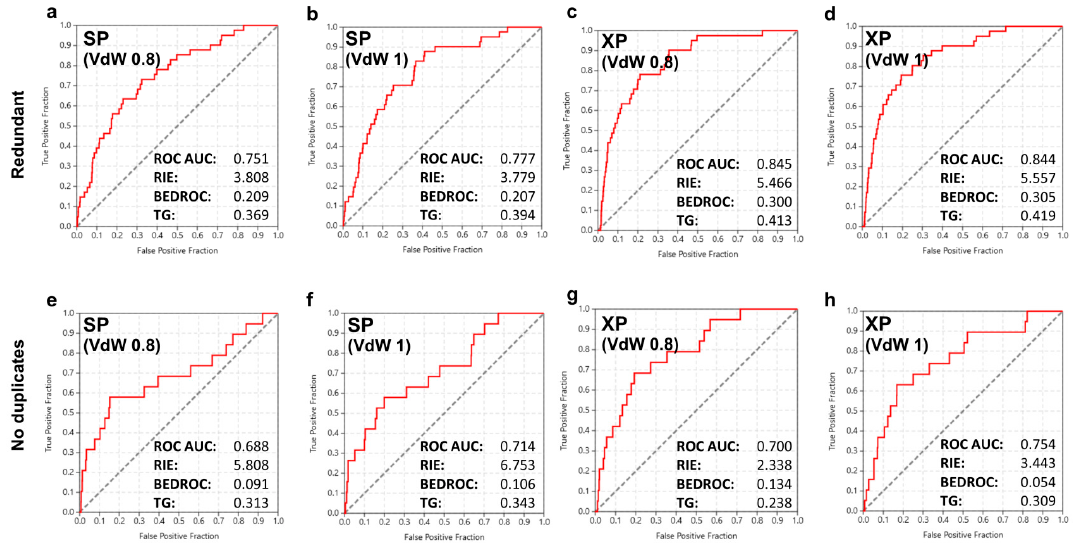
Figure 1. The receiver operating characteristic (ROC) curves and key enrichment metrics obtained for the initial structure-based screening of the NCI Diversity Set-II against CK1. In the first ( a – d ) and second ( e – h ) lines, data for screens following the two distinct approaches with respect to ranking of different possible states of screened compounds are depicted, as discussed in the text (redundancy treatment). The screening accuracy (SP or XP) and the Van der Waals scaling factors are shown inside the inlets. AUC: area under the curve; RIE: robust initial enhancement; BEDROC: Boltzmann- enhanced discrimination of ROC; TG: total